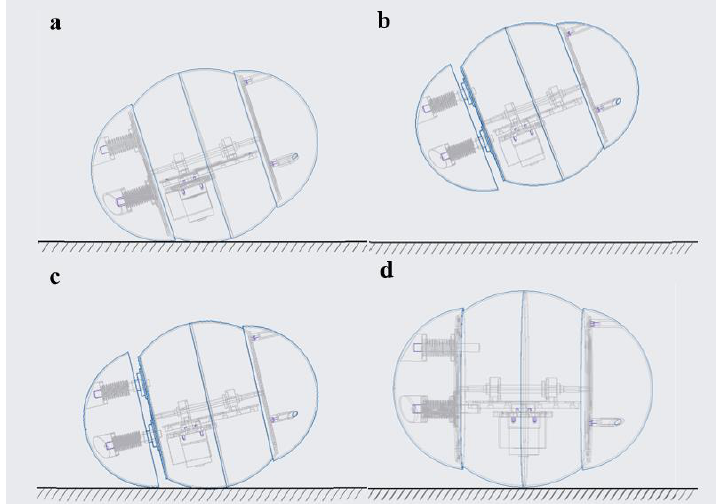
Figure 9. The jump process of the rolling and jumping robot: ( a ) The process of posture adjustment; ( b ) The process of energy release and jump; ( c ) The process of landing; ( d ) The process of energy storing for the next jump.